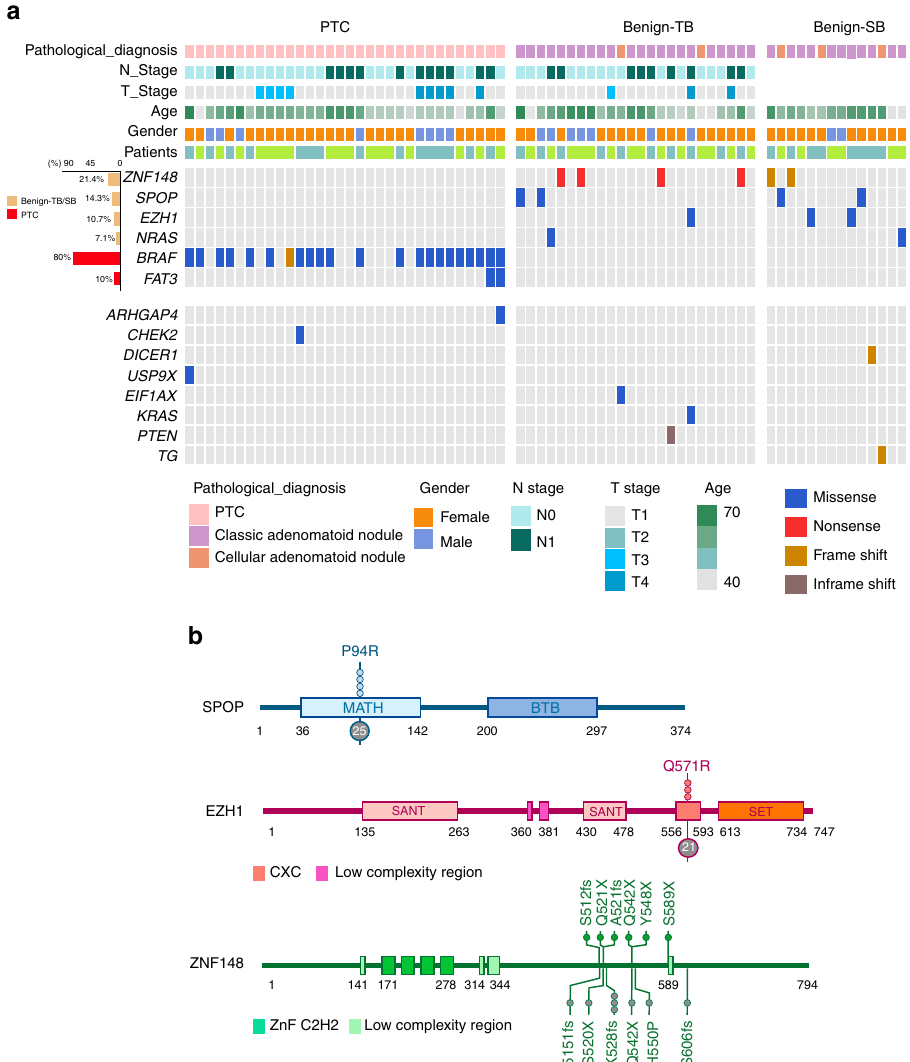
Figure 2 | Putative functional somatic mutations in thyroid tissues. ( a ) Landscape of significantly mutated gene and genes previously associated with PTC in thyroid tissues. The frequency of mutation in each sample type was indicated in the left histogram. ( b ) Schematic representation of mutations in SPOP, EZH1 and ZNF148. Conserved domains were indicated as boxes. Somatic mutations detected in our cohort were indicated in the upper. Somatic mutations of these three genes in expanding 231 patients were indicated in grey